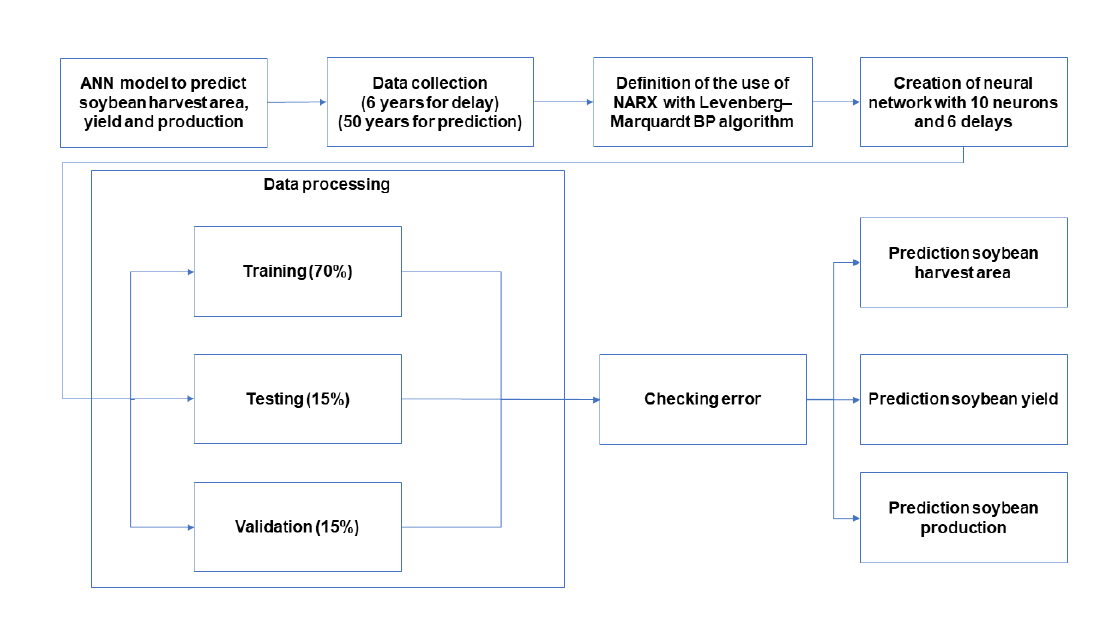
Figure 3. Flowchart of the ANN model.